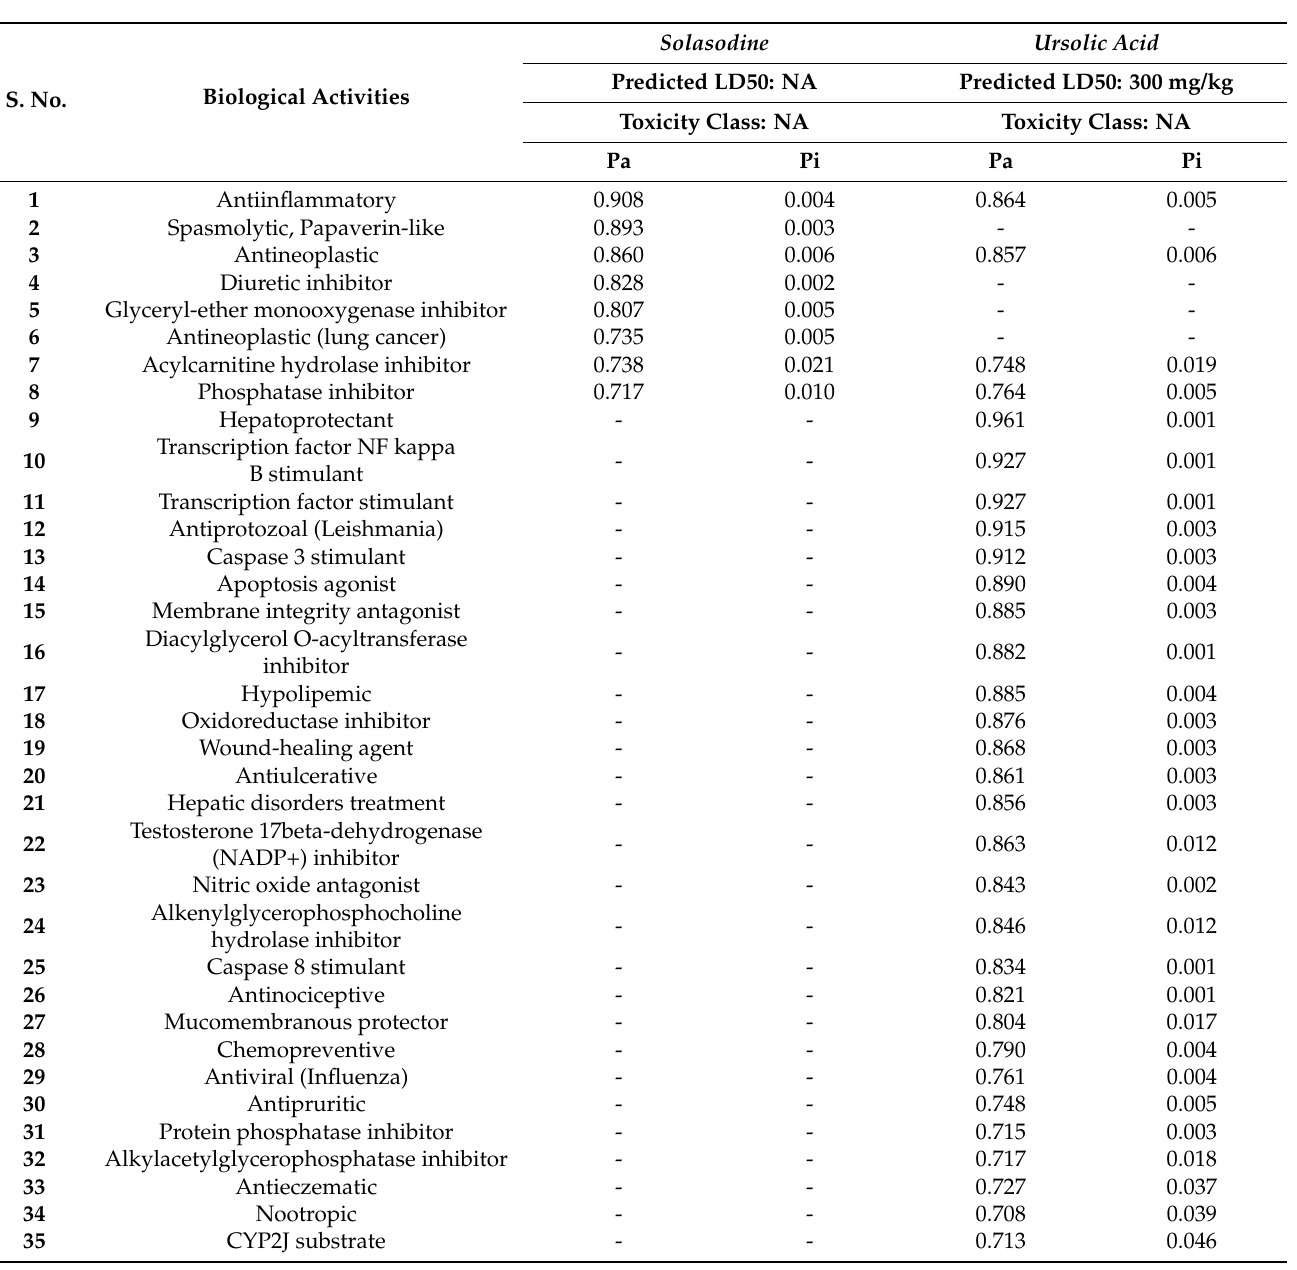
Table 5. Biological activities of selected ligands as per PASS prediction